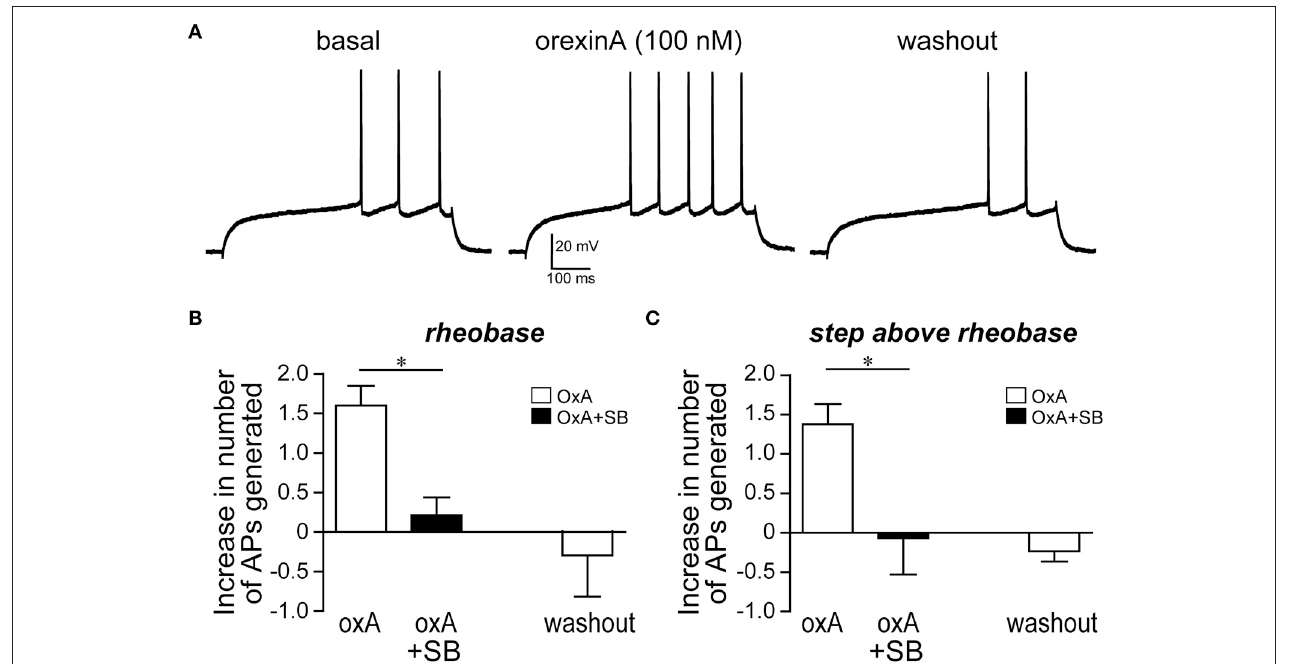
FIGURE 8 | OrexinA increased firing ex vivo in medial NAc Shell neurons from alcohol-drinking mice. (A) Example showing that 100nM orexinA (OxA) increased firing in the mNAsh neurons from adult alcohol-drinking mice; firing was evoked by 500-ms depolarizing current pulses (See Section Methods). Example is from rheobase, the minimum current required to evoke firing, in this neuron (B,C) Averaged data showing the increased number of action potentials generated with OxA (B) at rheobase, and (C) at the current step above rheobase, and that blocking OX1Rs with SB prevented the OxA increase in firing. * p <